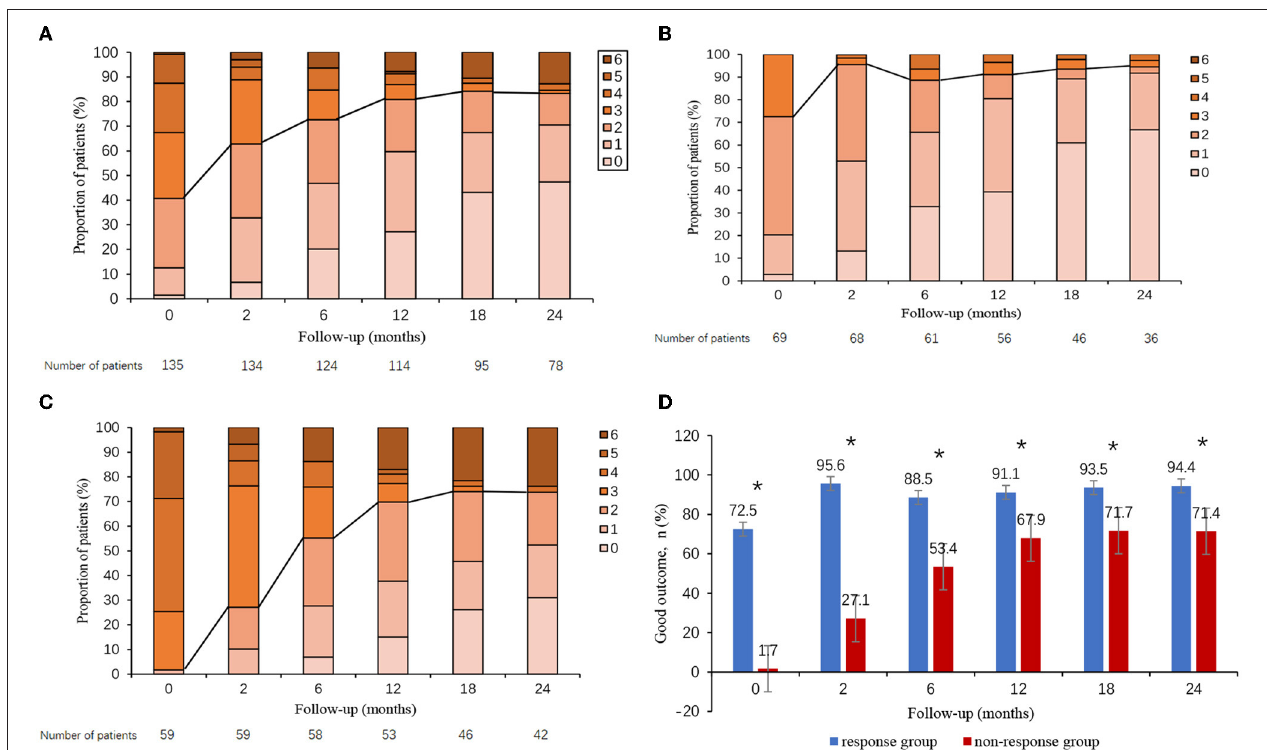
FIGURE 2 | Clinical outcome in autoimmune encephalitis patients. Clinical outcome in all patients (A) , patients who responded to short-term first-line immunotherapy (B) , patients who failed short-term first-line immunotherapy (C) , and overall proportion of patients with good outcomes according to short-term first-line treatment response (D) . The proportion of patients with good outcomes was significantly lower in non-responders than in responders. * p < 0.05.